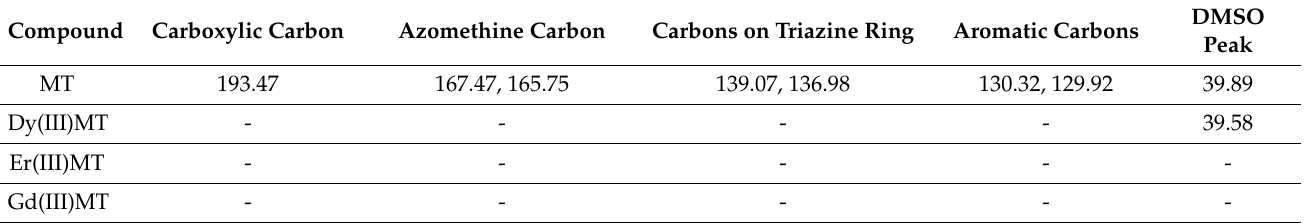
Table 5. 13 C-NMR data of 2,4,6-tris(4-carboxybenzimino)-1,3,5-triazine (MT) and its Ln(III) Complexes (ppm). Compound Carboxylic